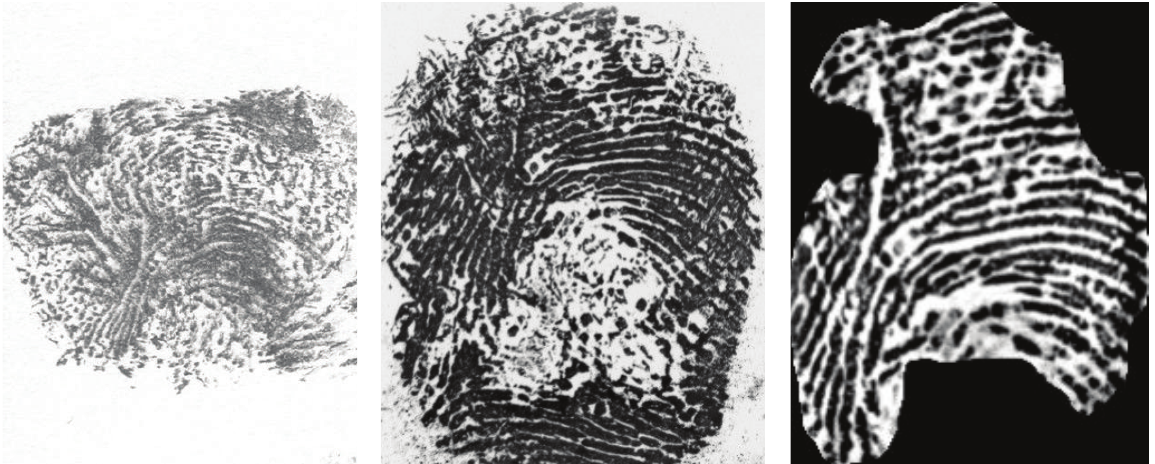
Figure 23: Fingerprints with light psoriasis (same person).